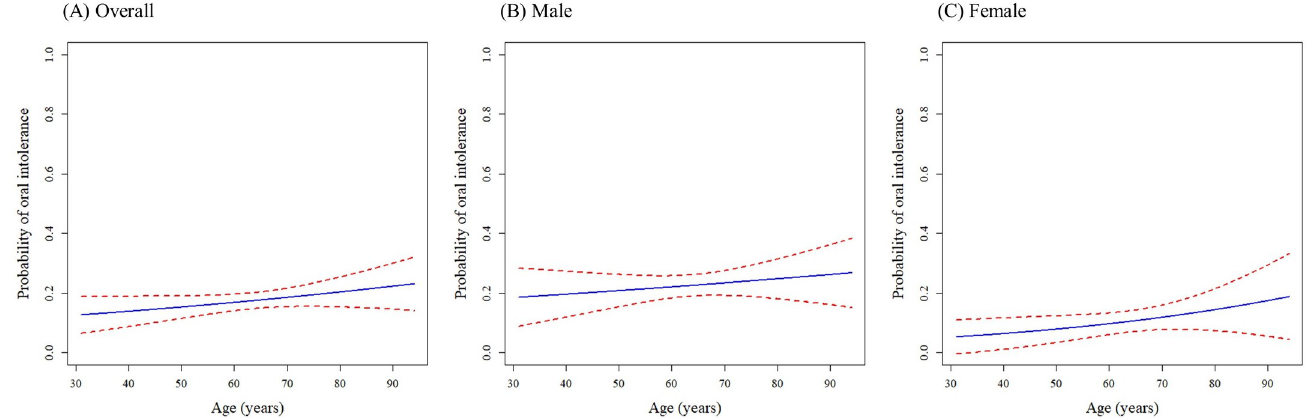
Fig 3. The multivariable fractional polynomials model showing the probability of intolerability to oral nutrition according to age. Probability was calculated using a regression model adjusting for sex. The dotted lines represent a 95% confidence interval of probability.